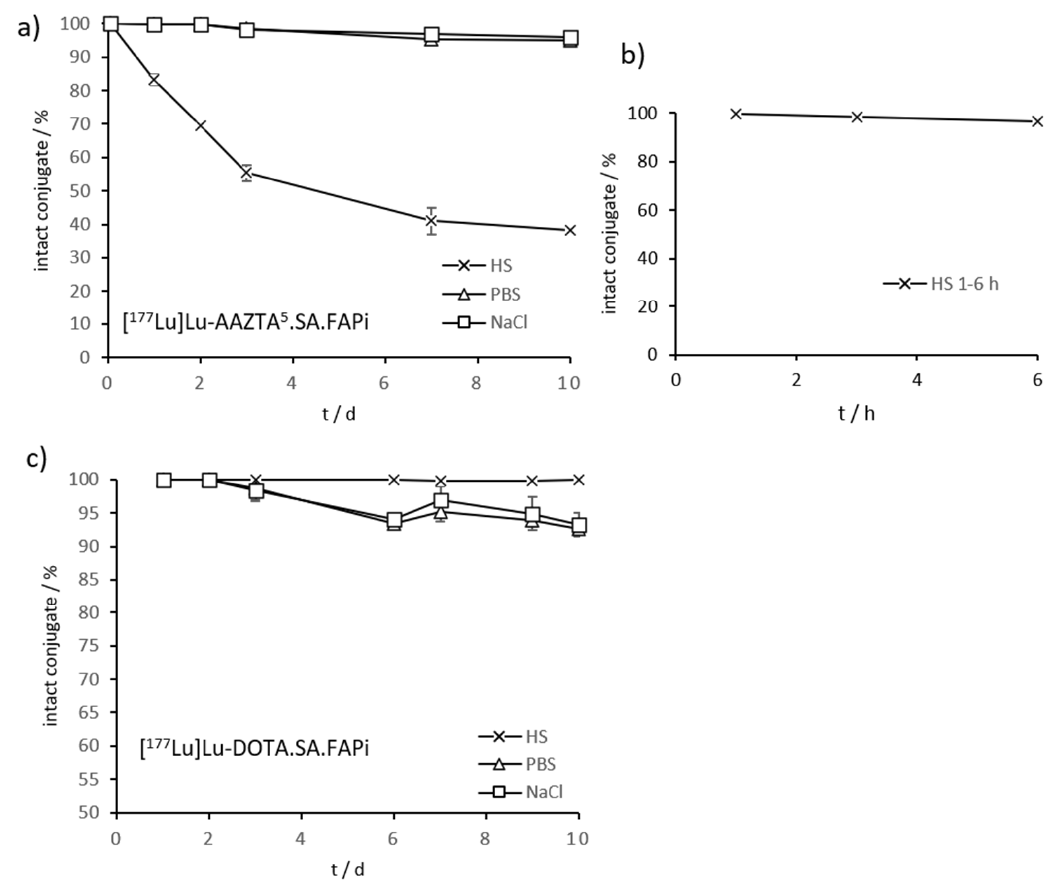
Figure 7. ( a ) Stability of [ 177 Lu]Lu-AAZTA 5 .SA.FAPi at 37 °C in HS, PBS, and NaCl over a period of 10 d ( n = 3); ( b ) Stability of [ 177 Lu]Lu-AAZTA 5 .SA.FAPi at 37 °C in HS after 1, 3, and 6 h ( n = 3); ( c ) Stability measurements of [ 177 Lu]Lu-DOTA.SA.FAPi at 37 °C in HS, PBS, and NaCl during 10 d ( n = 3).